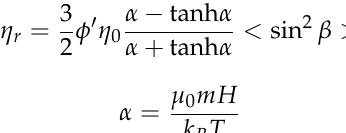
where η 0 is the zero magnetic field viscosity, φ ’ denotes the volume fraction of the particles including the surfactant, β denotes the angle between the vorticity of the flow and the magnetic field direction, α is the ratio of magnetic and thermal energy, µ 0 is the vacuum permeability, m is the magnetic moment of the particle, H is the magnetic flux density, k B is the Boltzmann’s constant, T is the absolute temperature and < . . . > denotes the spatial average of the respective